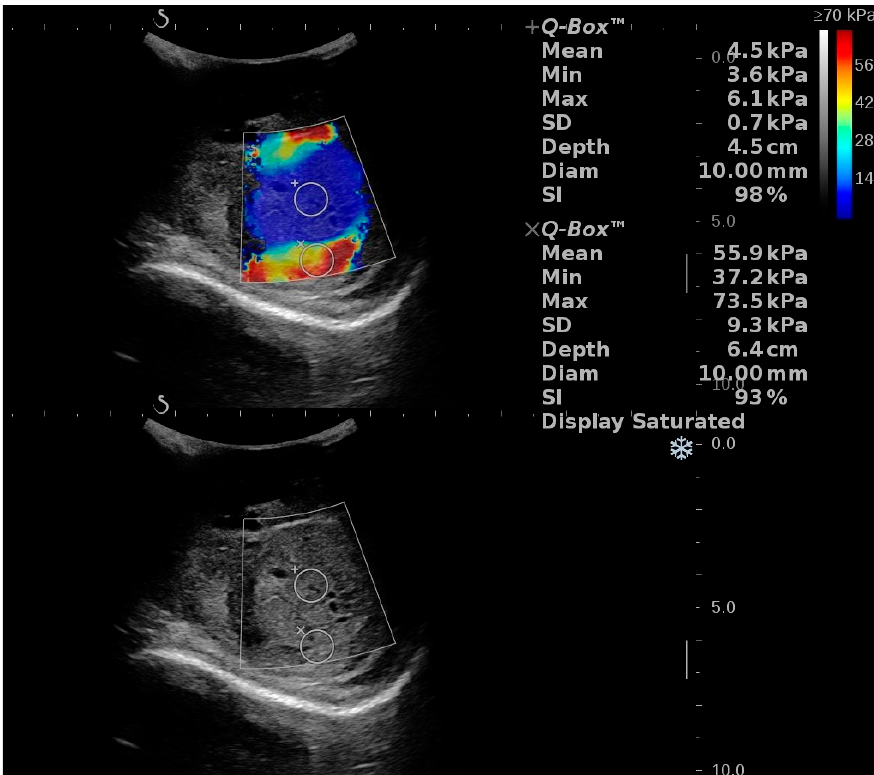
Figure 5. Illustration of a two-dimensional shear wave elastography (2D SWE) performed in a patient with a large testicular tumor using the SuperSonic Imagine Aixplorer Ultrasound device. A color scale map is displayed in the upper part of the image, low stiffness is color-coded with blue, while red signifies high stiffness. Numeric 2D SWE results (expressed in kPa) are displayed on the right side of the image. The Q-Box displays the mean, median, minimum, maximum and standard deviation (SD) of the measurements, along with the depth, the diameter of the region of interest (ROI), and the stability index (SI).